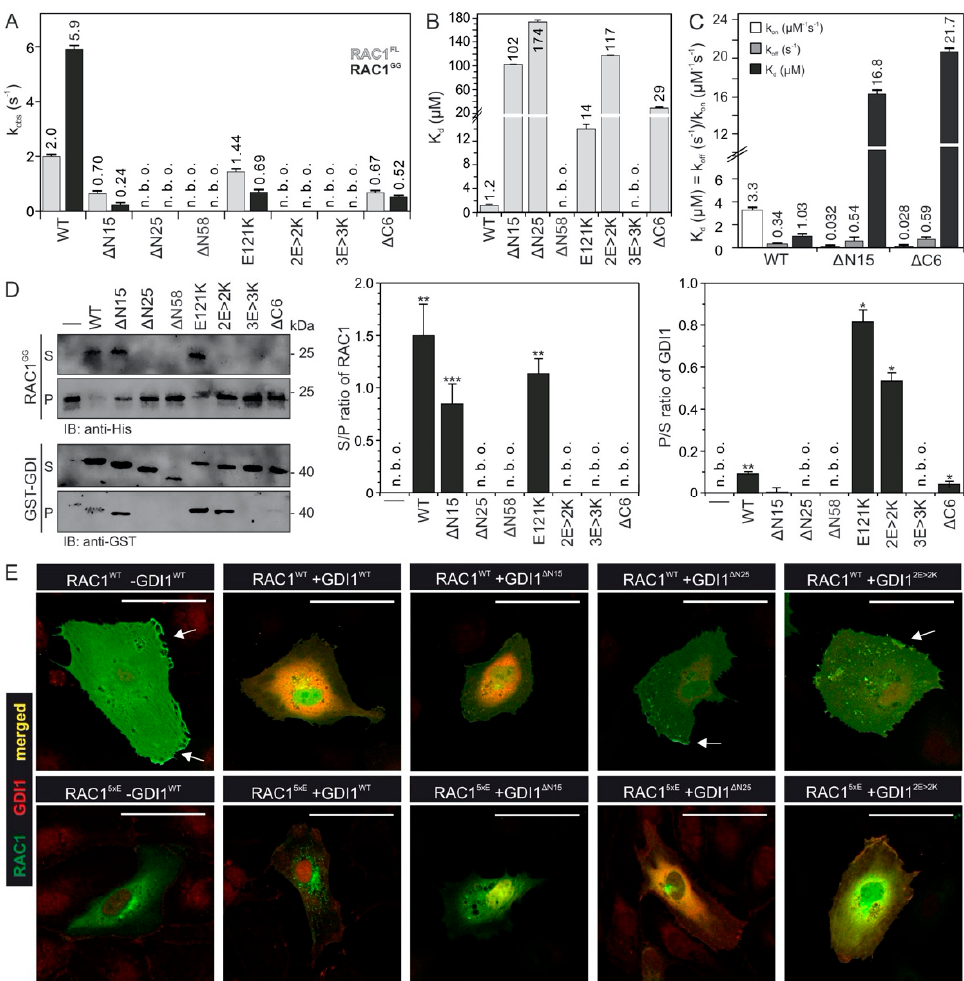
Figure 4. RHOGDI1 grasps basic HVR of RAC1 with multiple negatively charged residues. ( A ) Kinetics of association of 2 µ M GDI1 variants with 0.2 µ M mdGDP-bound RAC1 was monitored using stopped-flow fluorimetry. The obtained data are the average of four to six independent measurements (mean ± S.D.). Kinetic data are shown in Figure S6. ( B ) K d values for the interaction between the GDI1 variants and mdGDP-bound RAC1 were determined by fluorescence polarization (See Figure S7 for more details). ( C ) Individual rate constants were determined, under the same condi- tions as shown in Figure 1A–C, for the interaction of RAC1 with GDI1 WT, Δ N15 and Δ C6, respec- tively. Kinetic data were derived from the average of four to six independent measurements (mean ± S.D.). ( D ) GDI1 variants are, in contrast to GDI1 WT , impaired in extracting RAC1 GG from PIP-en- riched synthetic liposomes. The graphs represent densitometric analysis of three independent lipo- some sedimentation experiments (see Figure S8). Data are expressed as the mean of triplicate exper- iments ± standard deviation (unpaired t-test, * p < 0.05, ** p < 0.01, and *** p < 0.001). ( E ) FLAG-GDI1 variants were not able to extract YFP-RAC1 from the plasma membrane of HUVECs. All individual images are illustrated in Figure S9. Scale bar represents 50 µm. Arrow point to colocalization of RAC1 and GDI1 at the membrane ruffles. To analyze the function of the GDI variants in extracting RAC1 GG from the liposomes, we performed a liposome sedimentation assay established previously [34]. Therefore, we mixed PIP-enriched liposomes (200 µm in diameter) with GDP-bound RAC1 GG and iso- lated liposome-bound RAC1 GG from the pellet fraction (Figure 4D, first lane) after sedi- mentation. Next, 1 µM of RAC1 GG •GDP bound to liposomes was mixed with 2 µM of GDI1 WT and its variants (2 µM, respectively) to measure their ability to displace RAC1 GG from the liposomes. Figure 4D shows that GDI1 WT quantitatively displaced RAC1 GG from